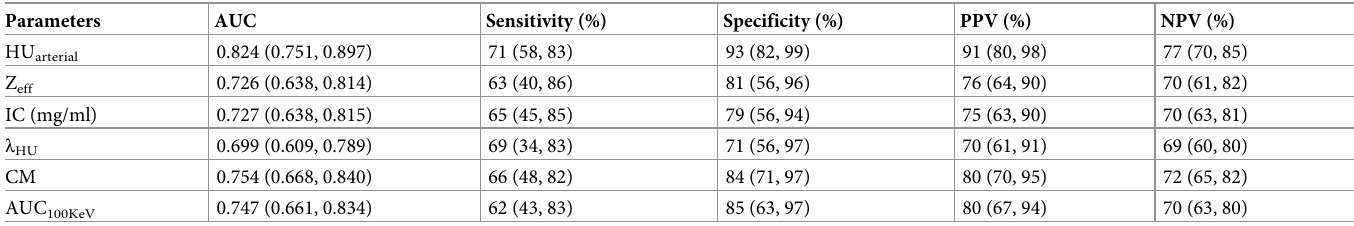
Table 4. Predictive performance of conventional and dual-energy CT parameters. Parameters